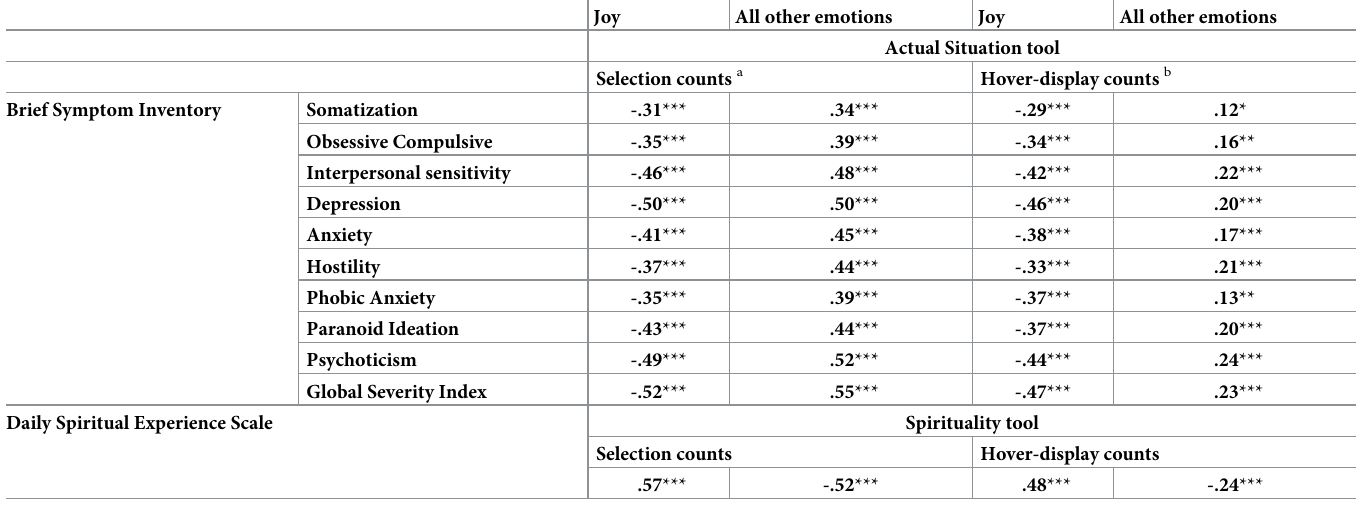
Table 7. Correlations of the Emotion Based Approach (EBA) actual situation tool and the EBA Spirituality tool (non-religious + god-image items) with the Brief Symptom Inventory and the Daily Spiritual Experience